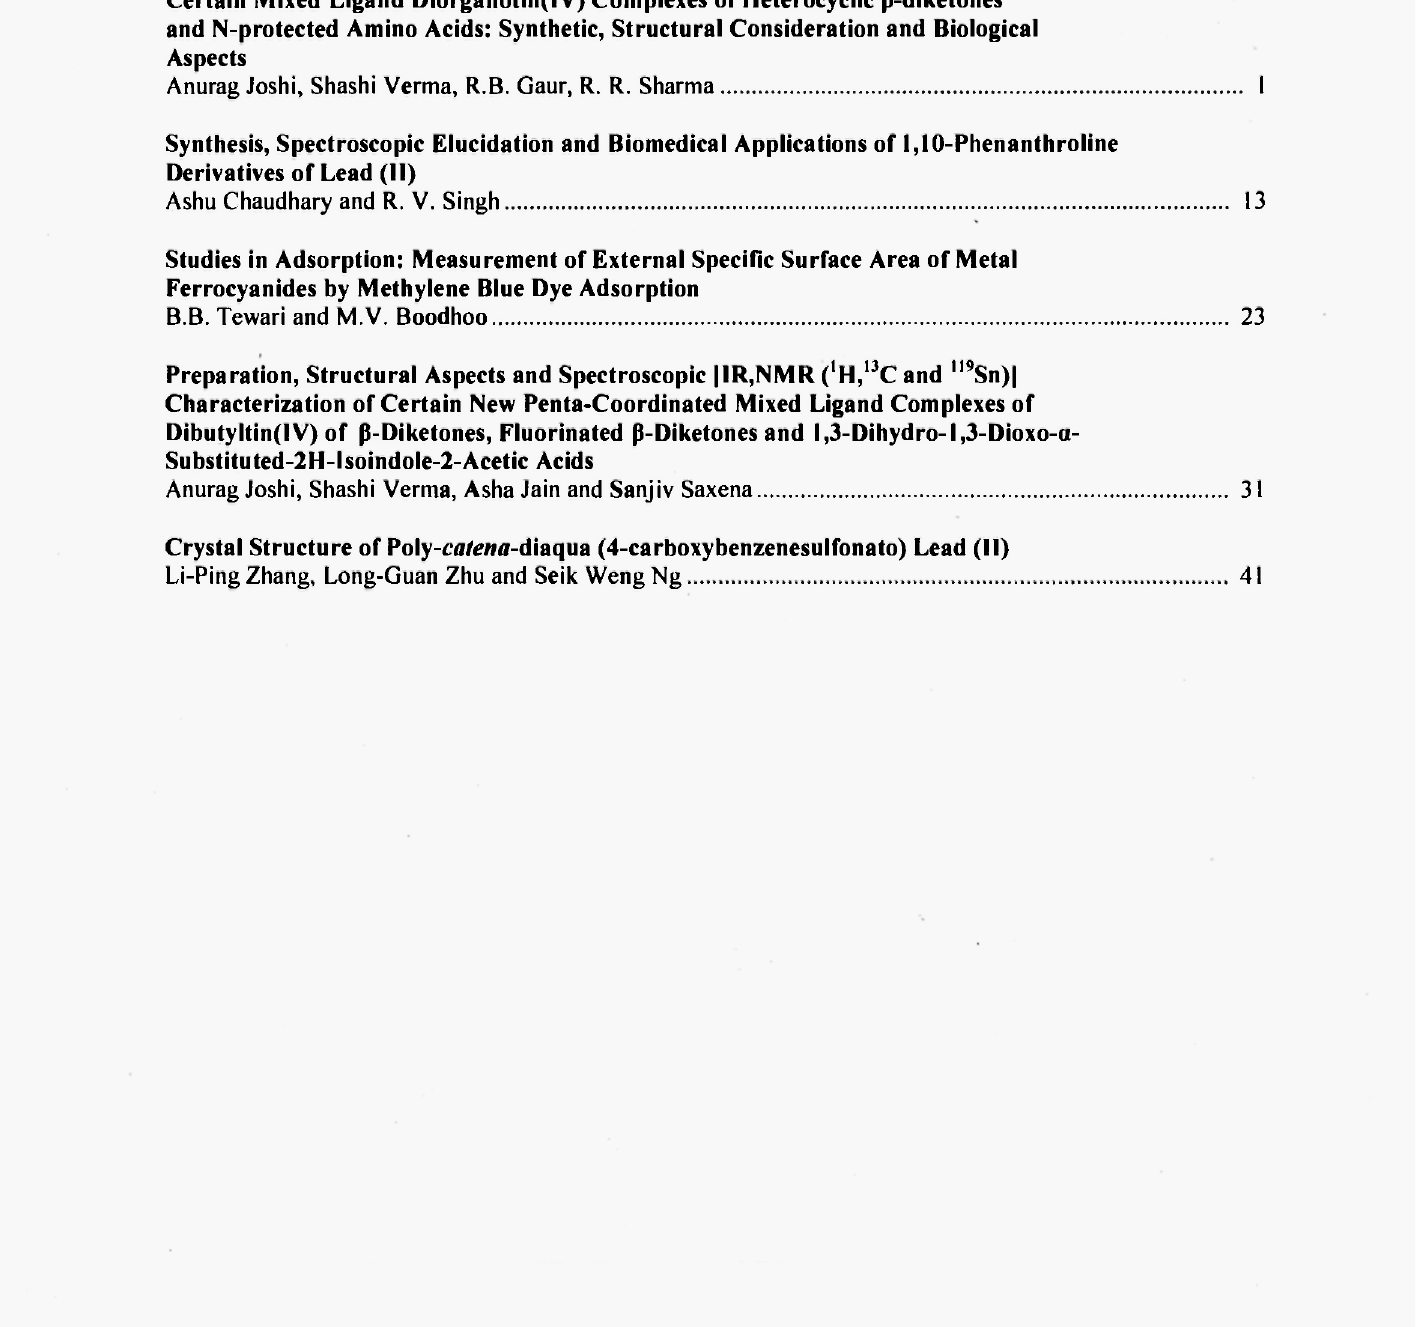
Synthesis, Spectroscopic Elucidation and Biomedical Applications of 1,10-Phenanthroline Derivatives of Lead (II)